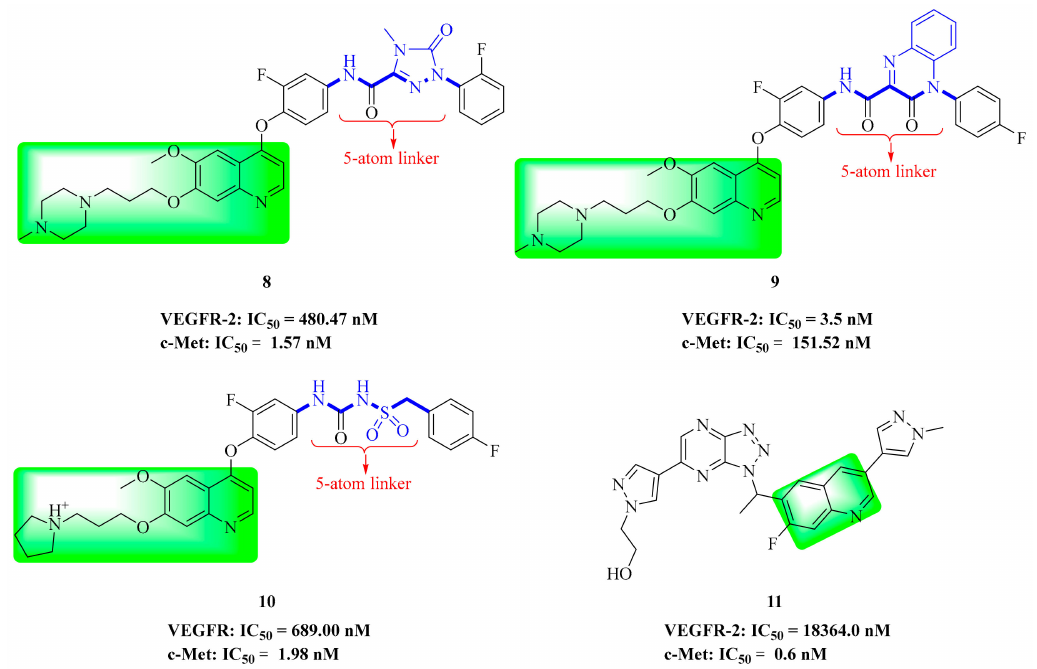
Figure 6. Quinoline derivatives of dual VEGFR / c-Met